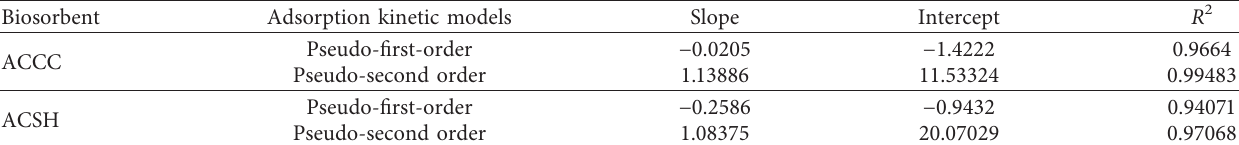
Table 2: Adsorption kinetic parameters.